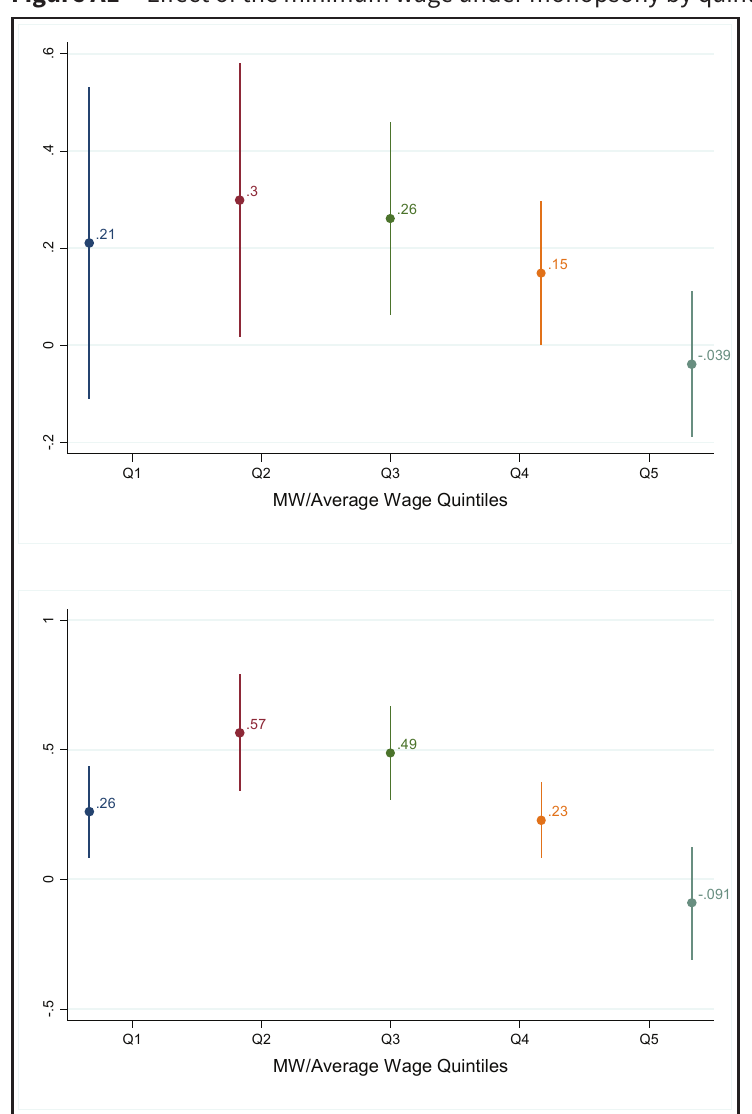
Effect of the minimum wage under monopsony by quintiles.